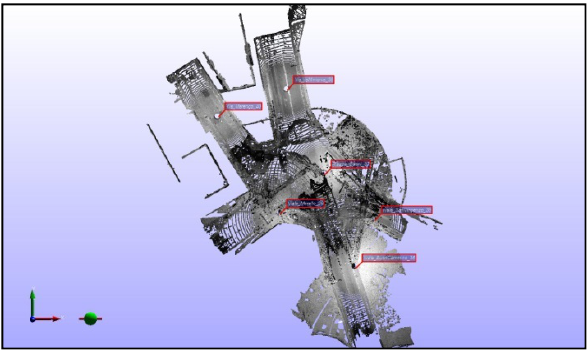
Figure 4. Location of the scans on the square